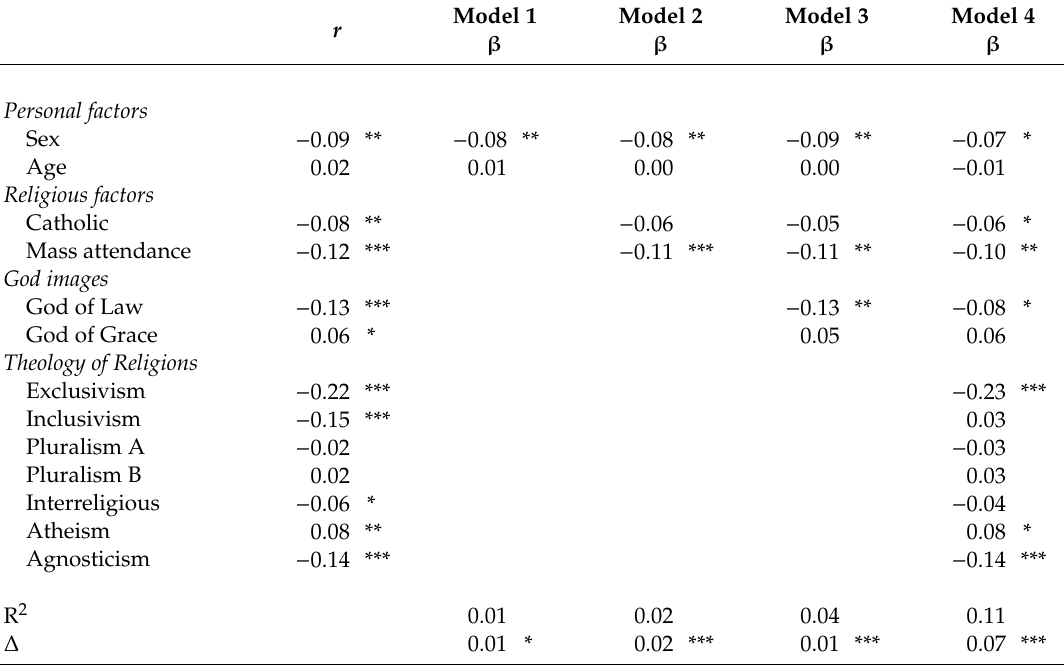
Table 4. Regression models.